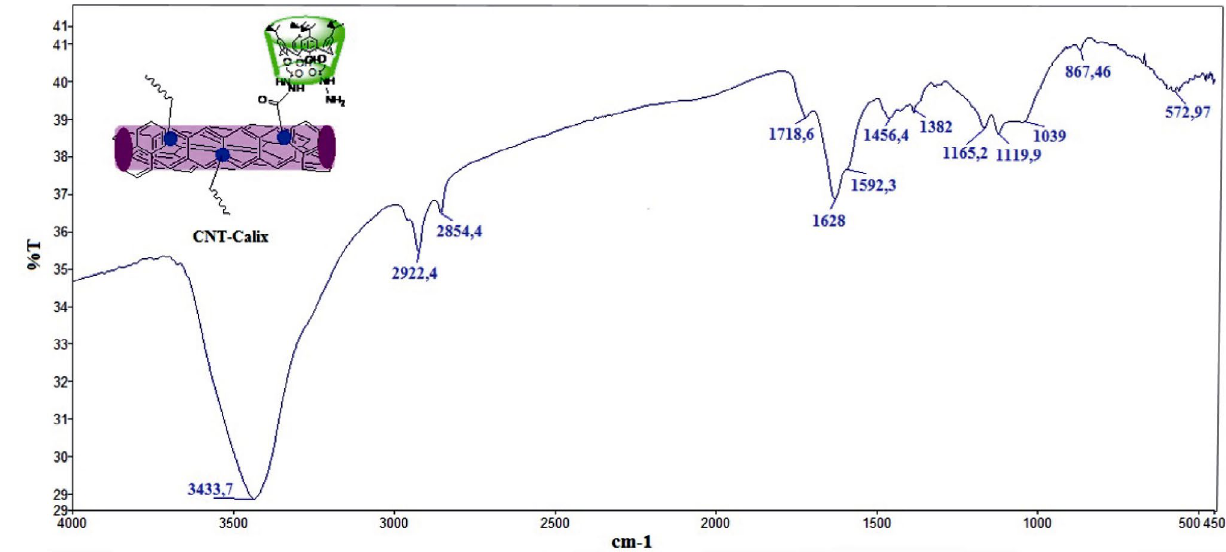
Fig. 1. FTIR spectra of CNT-Calix